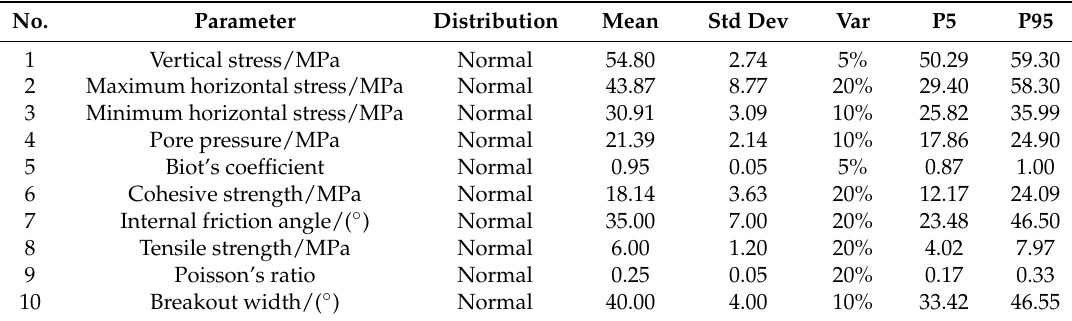
Table 1. Basic parameters for SMWW